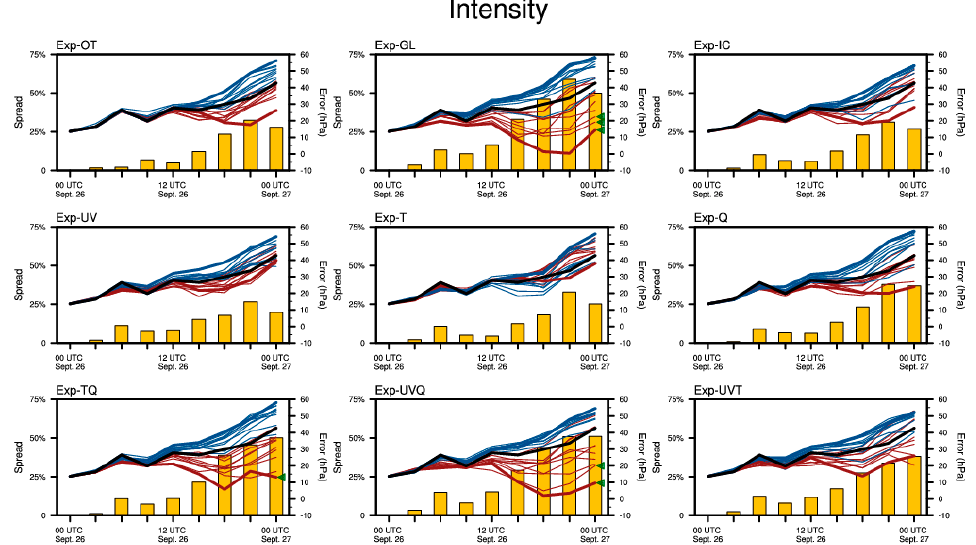
Figure 3. Same as Figure 2, but for the intensity in predetermined ensemble forecast experiments for Typhoon Dujuan (201521).